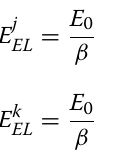
During the data transmission, all the sensors in different ring sectors have the same initial ELs. If there is UEL= β , EL of node j in Sr i and node k in Sr i − 1 are shown in Eqs. (16) and (17),